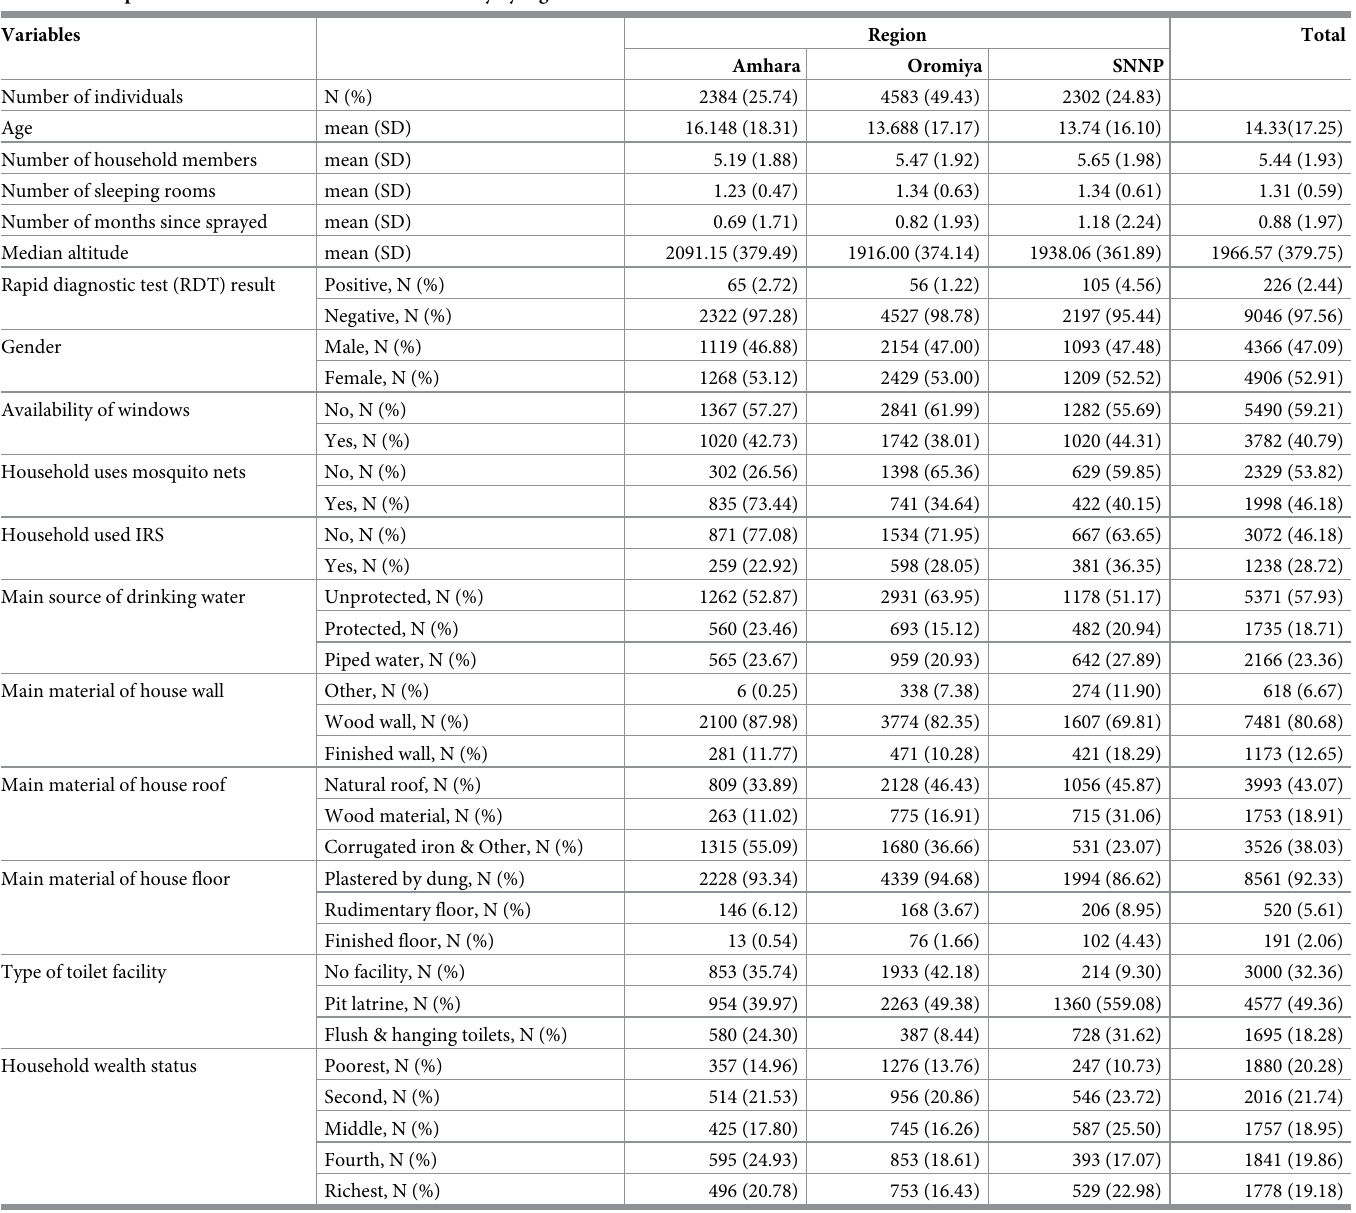
Table 1. Descriptive statistics for variables used in the study by